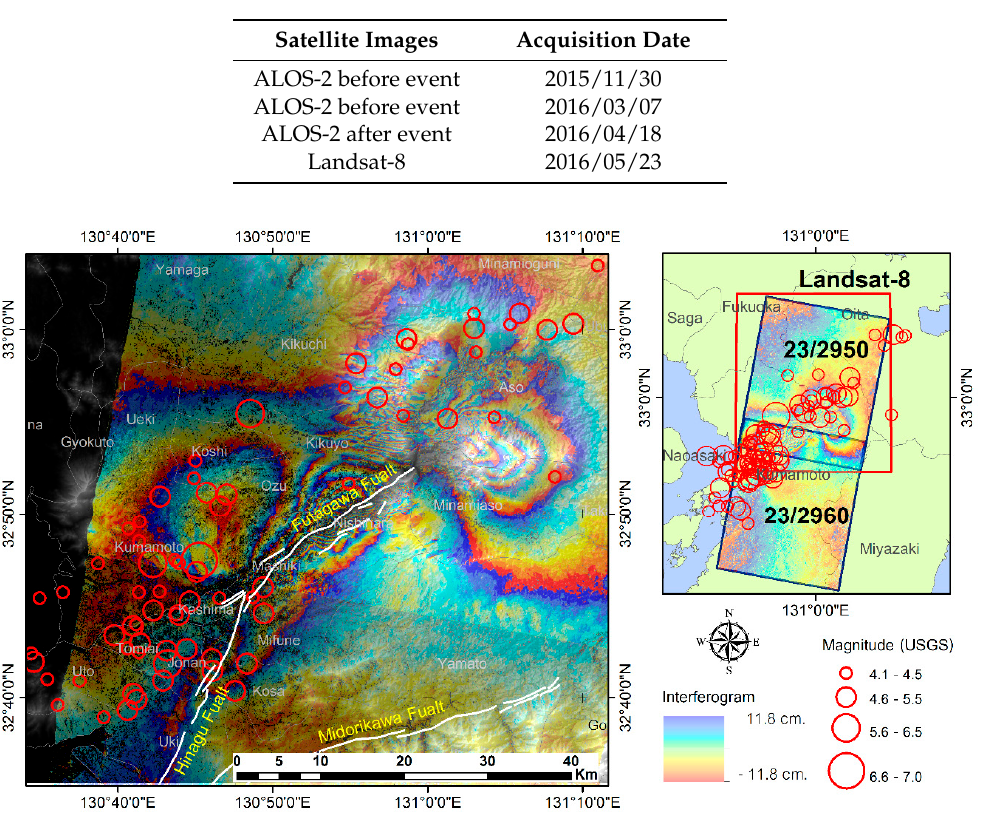
Figure 1. Elevation map of the study area derived from ASTER GDEM data and earthquake locations Figure 1. Co-seismic interferogram of the study area and earthquake locations with magnitudes of with magnitudes of more than 4.1 Mw between 14 April 2015 and 14 May 2015 from USGS. The more than 4.1 Mw between 14 April 2015 and 14 May 2015 from USGS. The earthquakes were mapped earthquakes were mapped along the Futagawa and Hinagu faults (fault line data sources: Geological along the Futagawa and Hinagu faults (fault line data sources: Geological Survey of Japan). The right Survey of Japan). The right map outlines the ALOS-2 PALSAR2 and Landsat-8 images used in this study. map outlines the ALOS-2 PALSAR2 and Landsat-8 images used in this